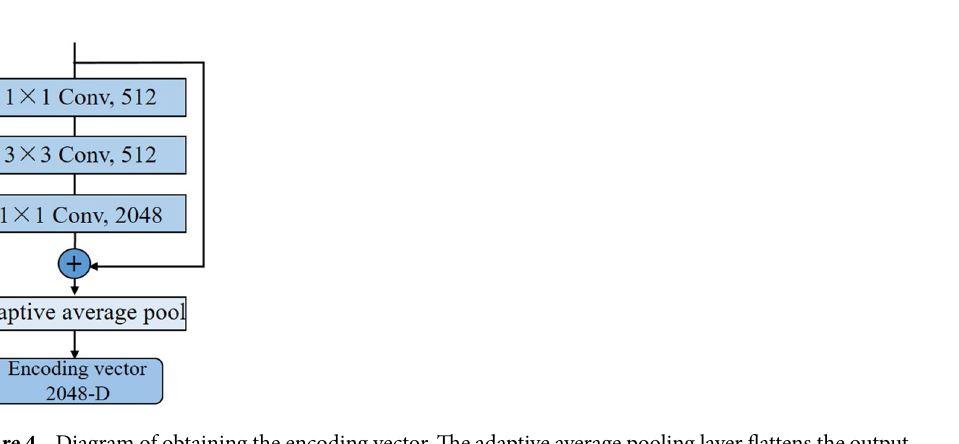
Figure 3. An example showing the image patches selected by the KREM. The left is the input image, and the right is the densest area of cell nuclei on three scales selected from image after performing six view transformations. First, second and third are the scale levels.